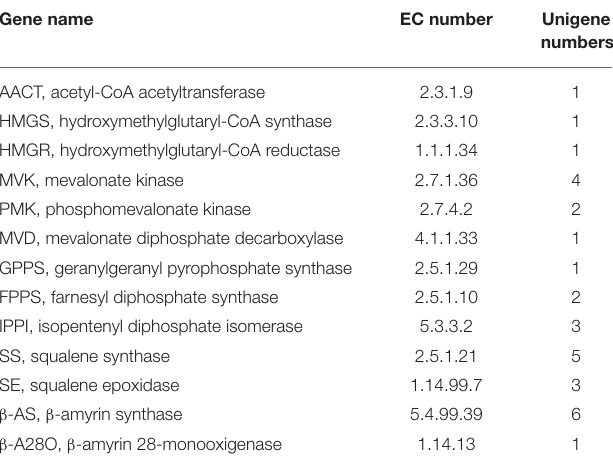
TABLE 3 | Unigenes involved in triterpene saponin biosynthesis pathway from D. asperoides.